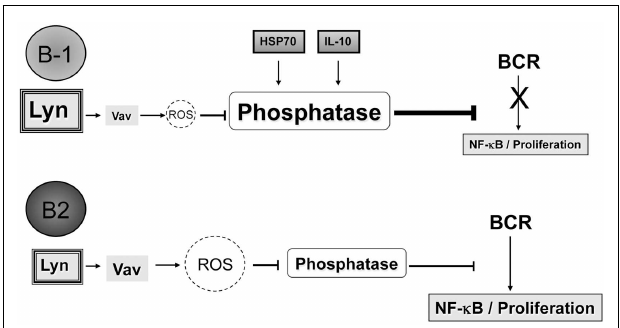
FIGURE 5 | Differences inVav proteins, IL-10, and/or HSP70 expression between B-1a and B2 cells lead to the inability of B-1a cells to activate NF- κ B and proliferate after BCR ligation . It is hypothesized that B-1a cells have increased levels or differential expression of phosphatases as compared to B2 cells, which could be at least partially the result of the increased basal expression of IL-10 and/or HSP70 seen in B-1a cells but not B2 cells. Furthermore, suboptimalVav levels in B-1 cells (35) may not be sufficient for the production of ROS, which are necessary to inhibit phosphatases to allow activation of NF- κ B after BCR ligation. Over-expression of the src kinase Lyn may also play a role in the non-response of B-1a cells to BCR ligation, perhaps by phosphorylation of inhibitory receptors.The mechanism through which Lyn contributes to B-1a cell non-responsiveness to BCR ligation is not clear; however, it has been demonstrated blocking Lyn activity can allow B-1a cells to respond to respond to BCR